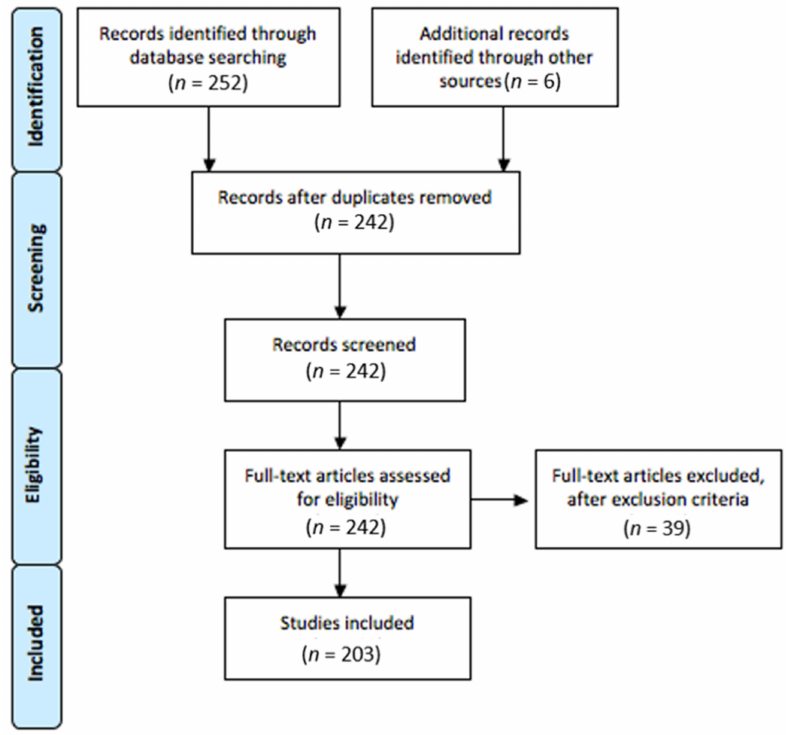
Figure 1. PRISMA Flow